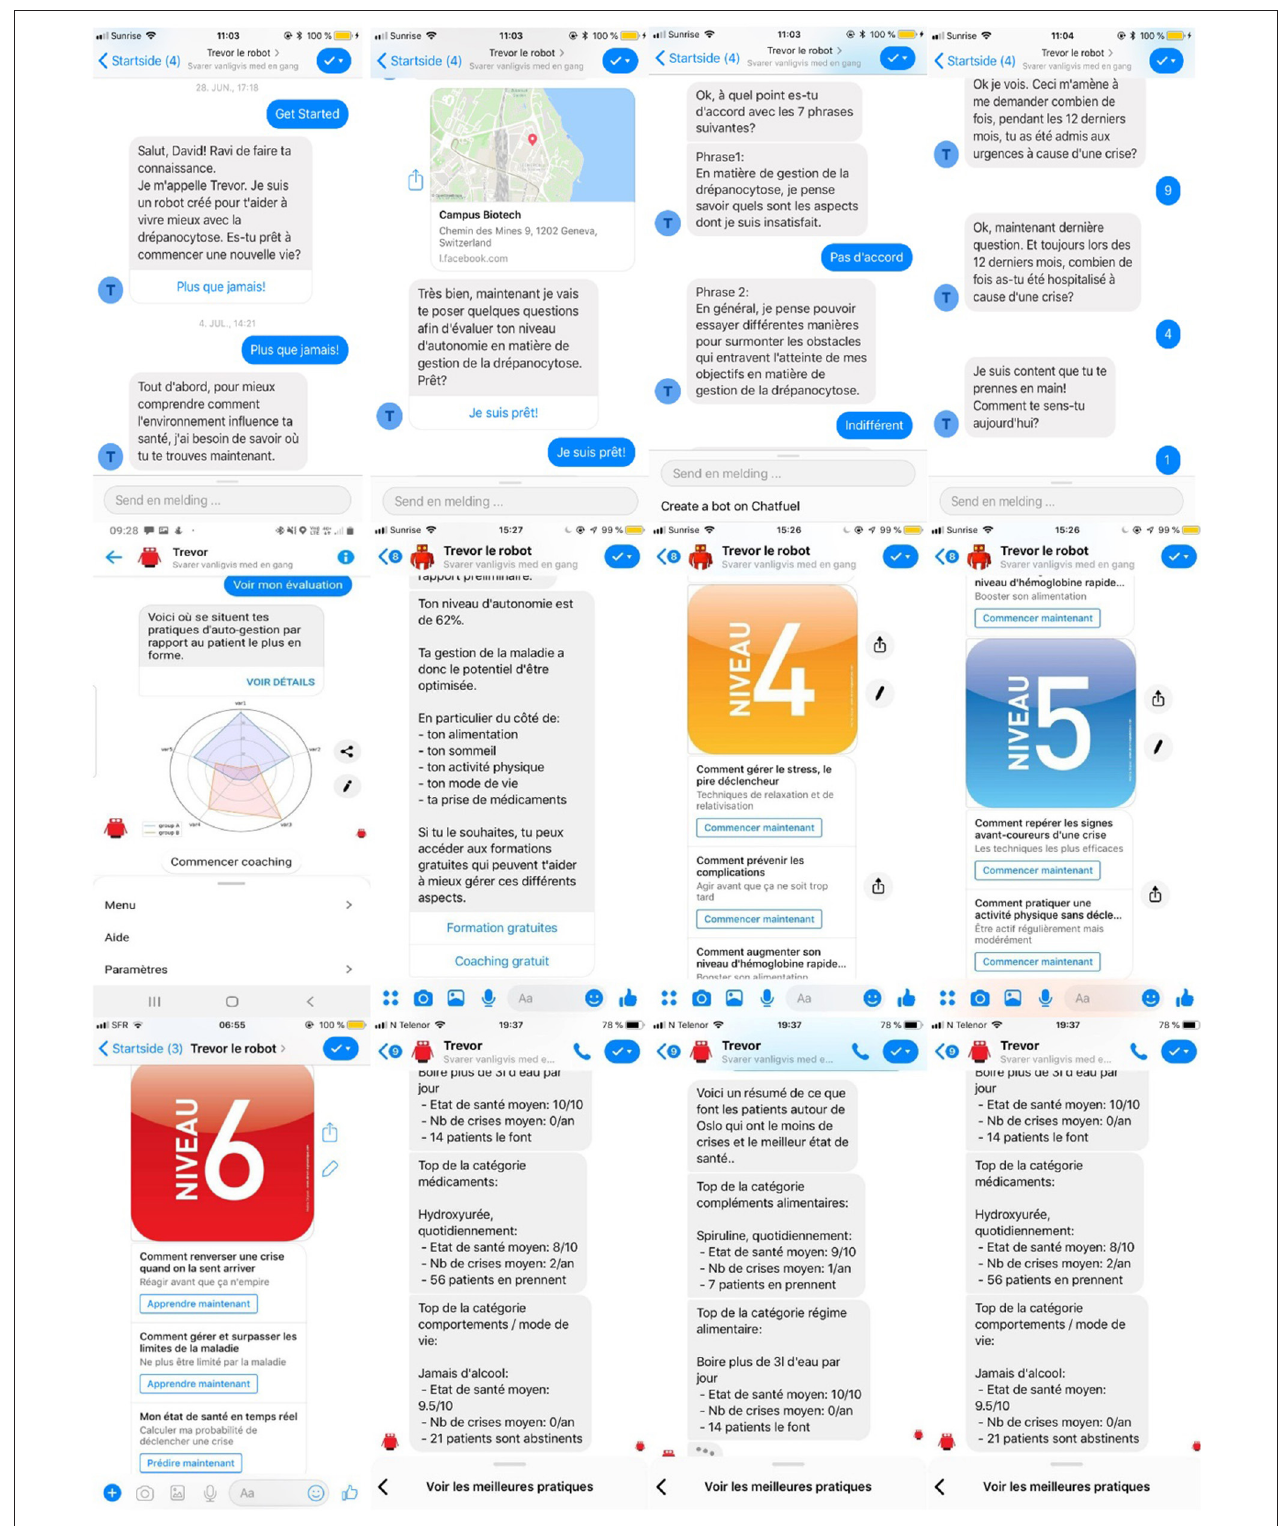
FIGURE 1 | Snapshots of TREVOR conversational